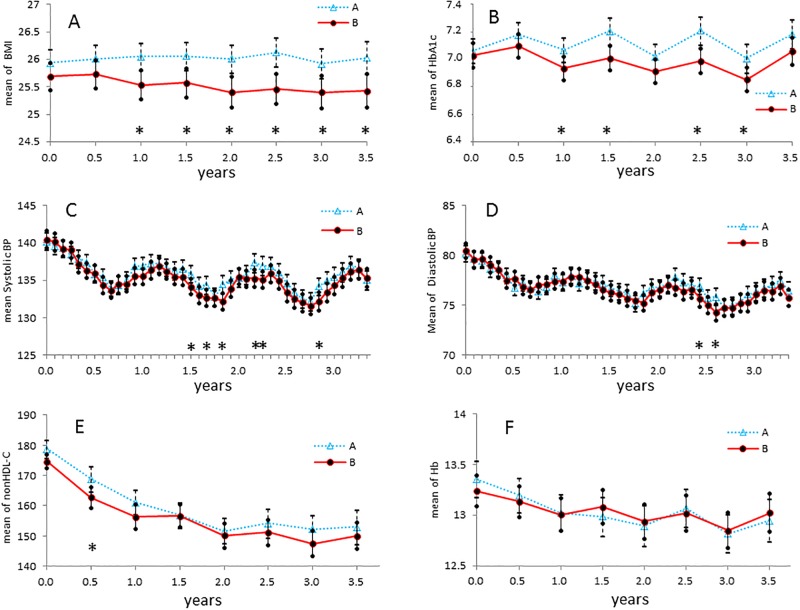
Effects of advanced CKD care system on CKD treatment targets.Items were BMI changes (A), HbA1c changes (B), systolic (C) and diastolic blood pressure changes (D), non-HDL cholesterol changes (E), and hemoglobin changes in subjects with Stage 3 CKD or later (F) during the study period. Patients in group B had greater improvements than those in group A in terms of the CKD practice guide targets, except for hemoglobin level. In particular, BMI, HbA1c, and blood pressure differences between group A and group B gradually increased over the time course of the interventions. Average BMI was significantly reduced in group B patients 2 years after starting the advanced intervention, and HbA1c was also significantly reduced in group B patients 2.5 years after starting the advanced intervention. * indicates p<0.05 between group A and group B by Student’s T test.